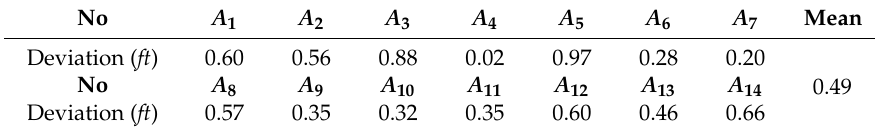
Table 3. The final deviation of path tracking for each aircraft (1 ft = 0.3048 m ).